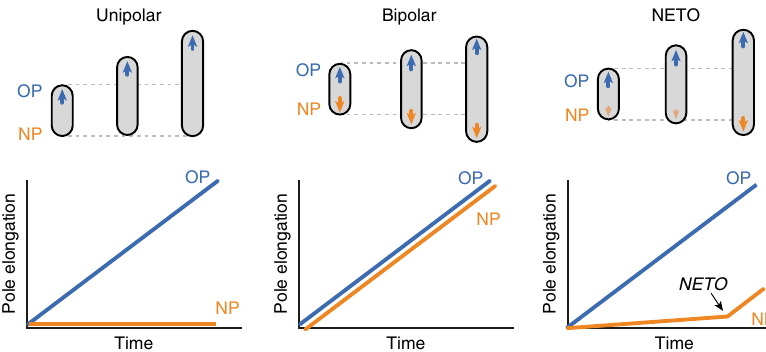
Fig. 3 Unipolar, bipolar, and NETO pole growth models in mycobacteria. Schematic representation of the elongation curves for the old pole (OP, blue) and the new pole (NP, orange) of a cell from birth (division of the mother cell) to division, according to the unipolar 2 , bipolar 3 , and NETO